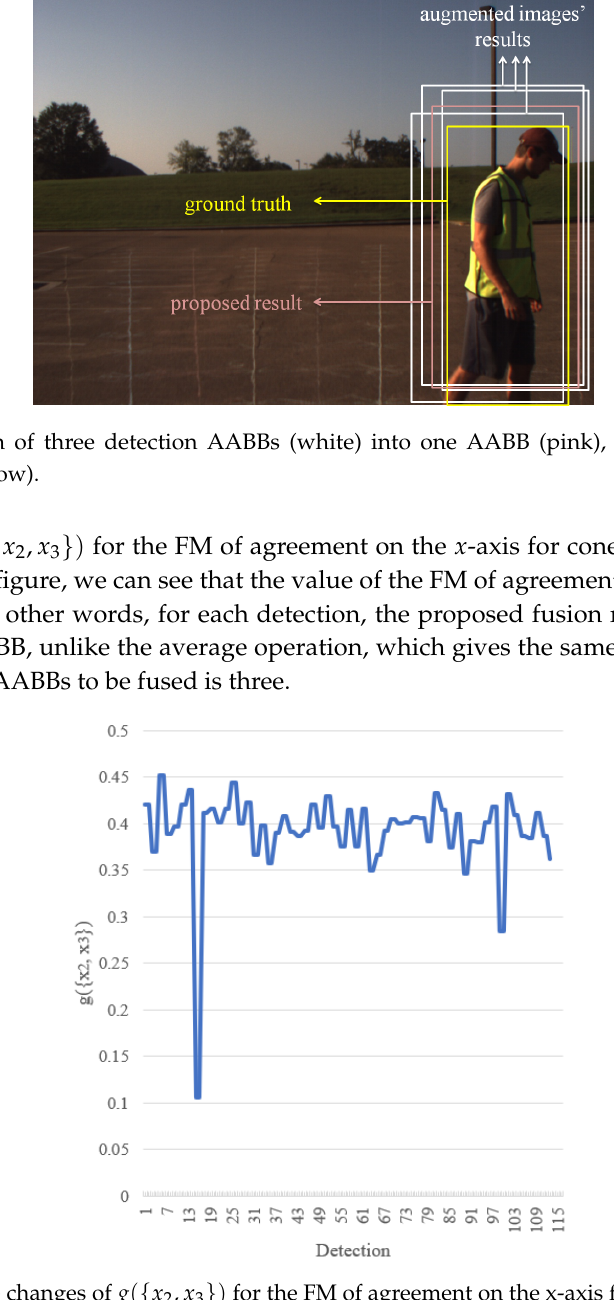
Figure 12. Value changes of g ( { x 2 , x 3 } ) for the FM of agreement on the x-axis for cone